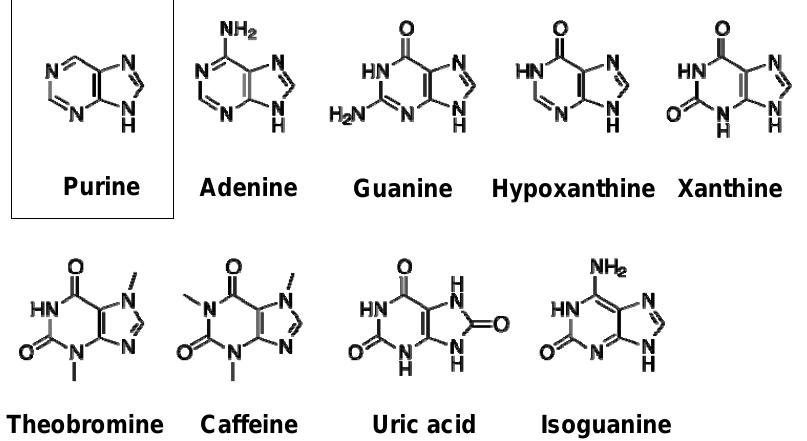
Figure 1. Chemical structures of purine and its derivatives, i.e. , adenine, guanine, hypoxanthine, xantine, theobromine, caffeine, uric acid, and